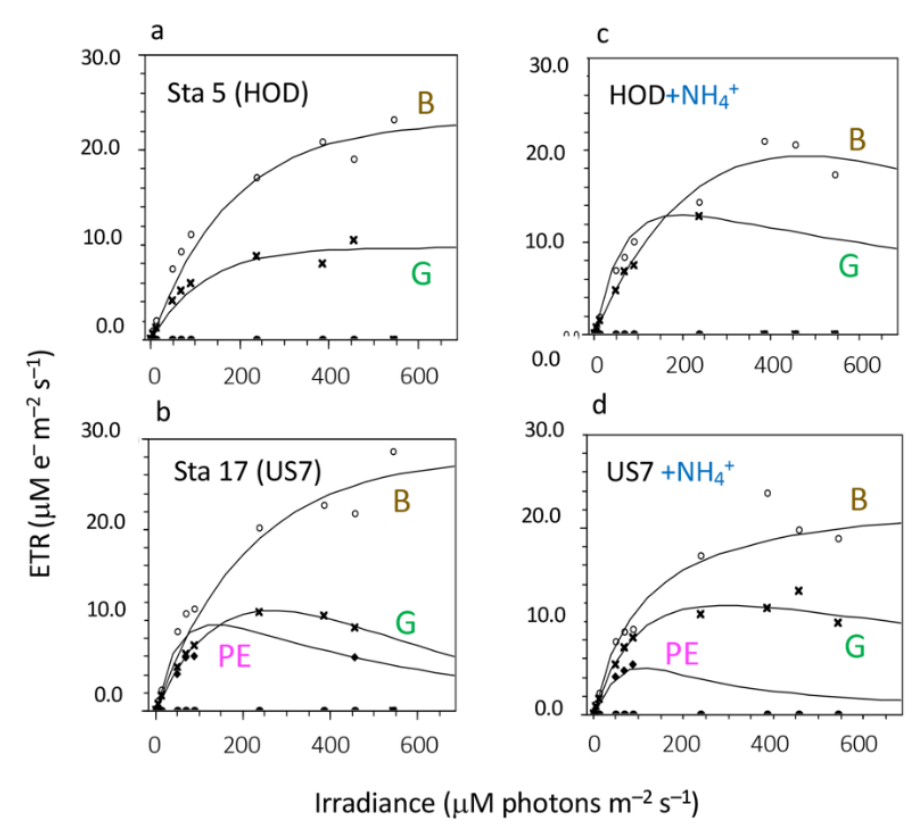
Figure 10. Rapid Light Curves for stations Station 5 (HOD; panel a ) and Station 17 (US7; panel b ) and the effects of pre-treatment (6 h) with 30 mM NH 4+ (panels c , d ). Curves were generated using Walz WinControl software according to Platt et al. [60]. The algal groups are differentiated as brown (B, diatoms), green (G, chlorophytes) and as phycoerythrin-containing cells (PE). Parameters are summarized in Table 3. Table 3. Parameters from Rapid Light Curves measured at stations and under conditions indicated. Ambient samples were dark adapted for 20 min. NH 4+ enriched samples were measured approxi-